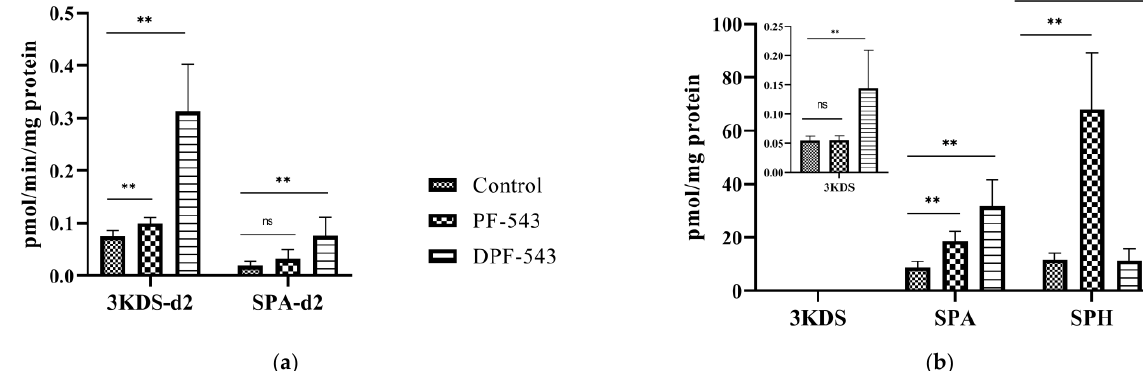
Figure 3. ( a ) Deutralized KDS and SPA accumulation by PF-543 and DPF-543; ( b ) PF-543 and DPF-543 impact on endogenous sphingoid bases. Data are shown as means ± SD, ns—not significant, ** p < 0.01.